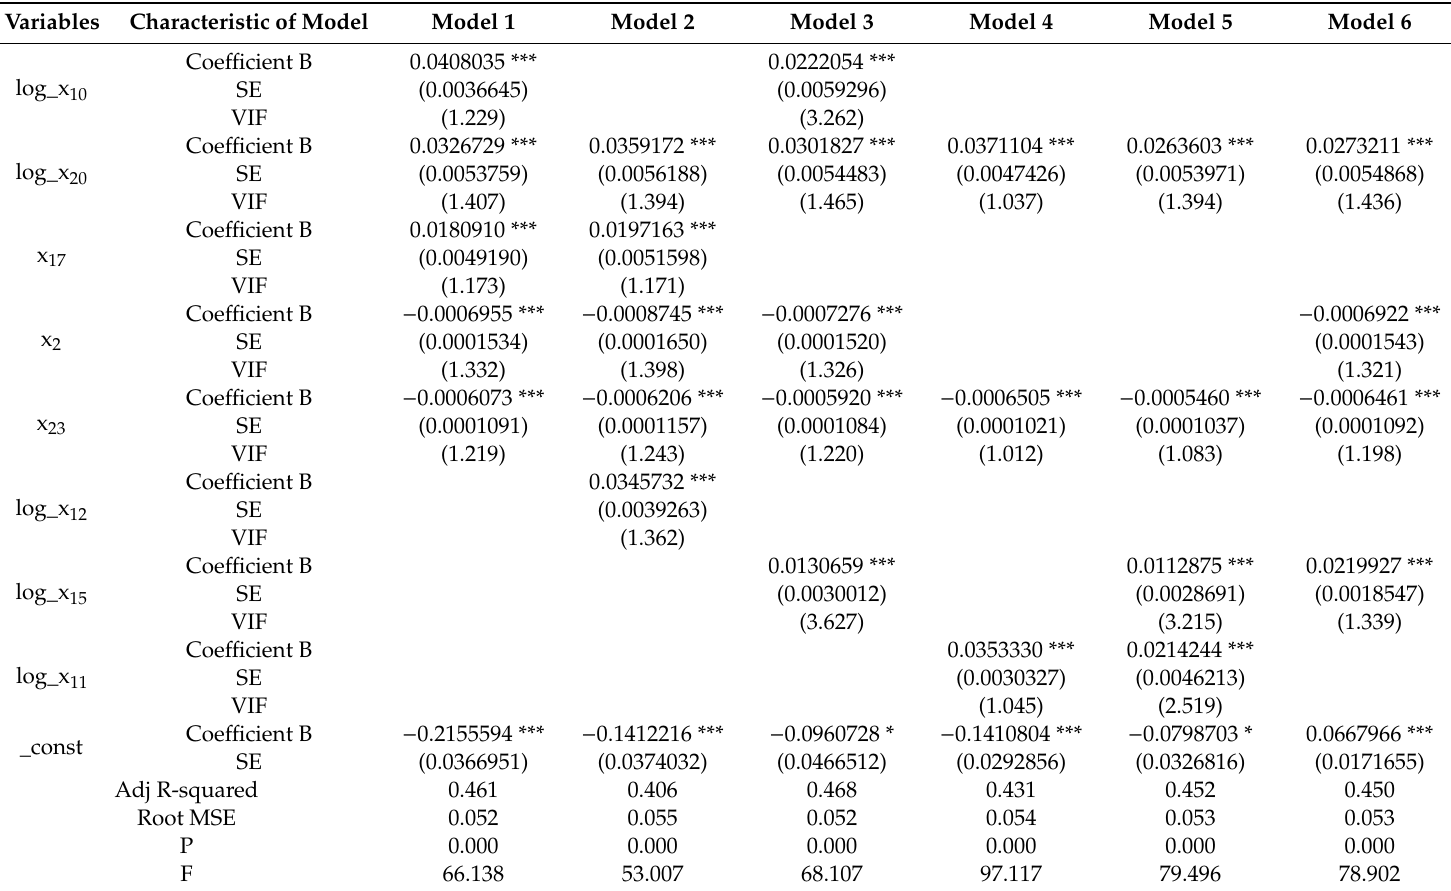
Table 4. Results of building regression models by the method of estimating the least squares